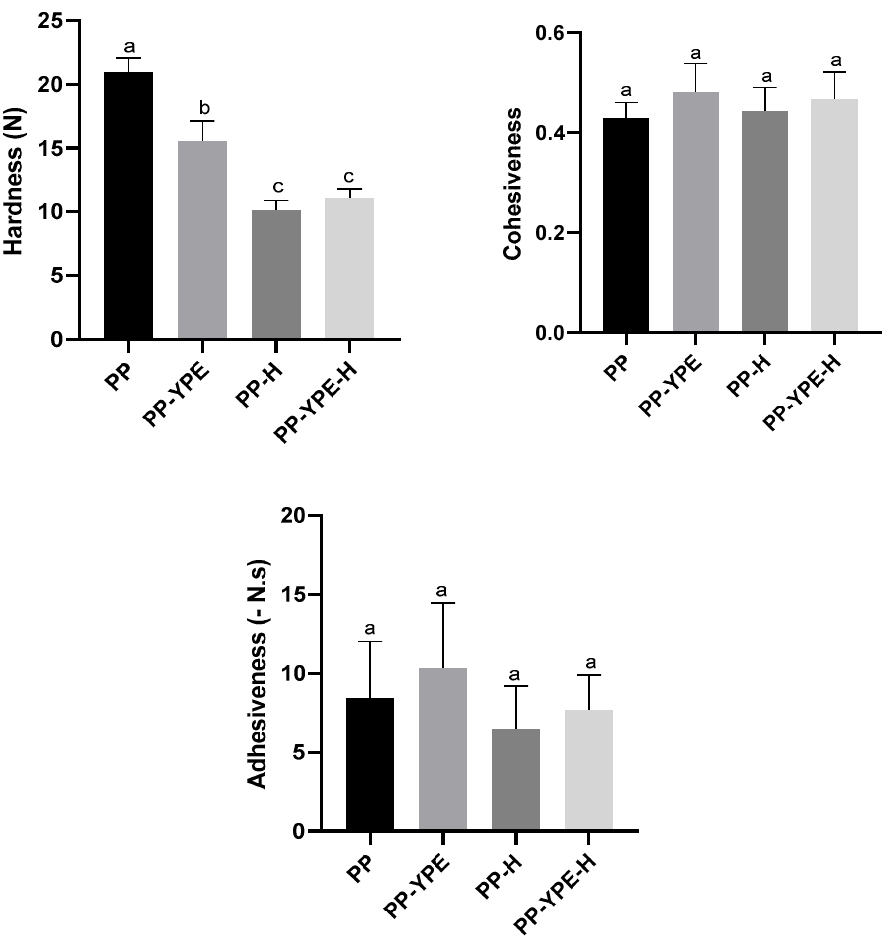
Figure 5. Hardness (N), cohesiveness and adhesiveness (-N.s) values of PP samples enriched with YPE (PP-YPE) and subjected to thermal treatment (PP-H and PP-YPE-H). Samples are presented as mean, with error bars indicating the standard deviations from the repetitions. In the same graph, different letters correspond to significant differences ( p < 0.05).